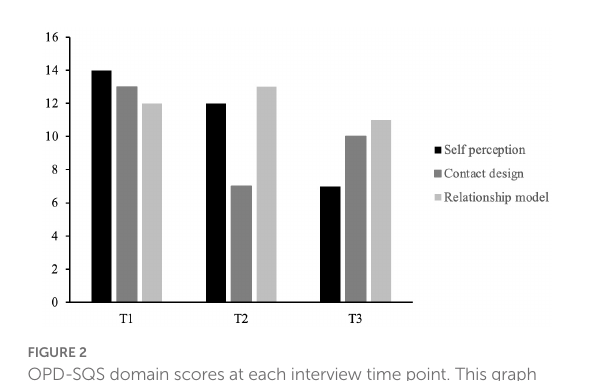
FIGURE 1 Back’s depression inventory-II scores at each interview time point. ranges from 0 to 63. Dashed lines represent the cut-off thresholds for mild and moderate depression.